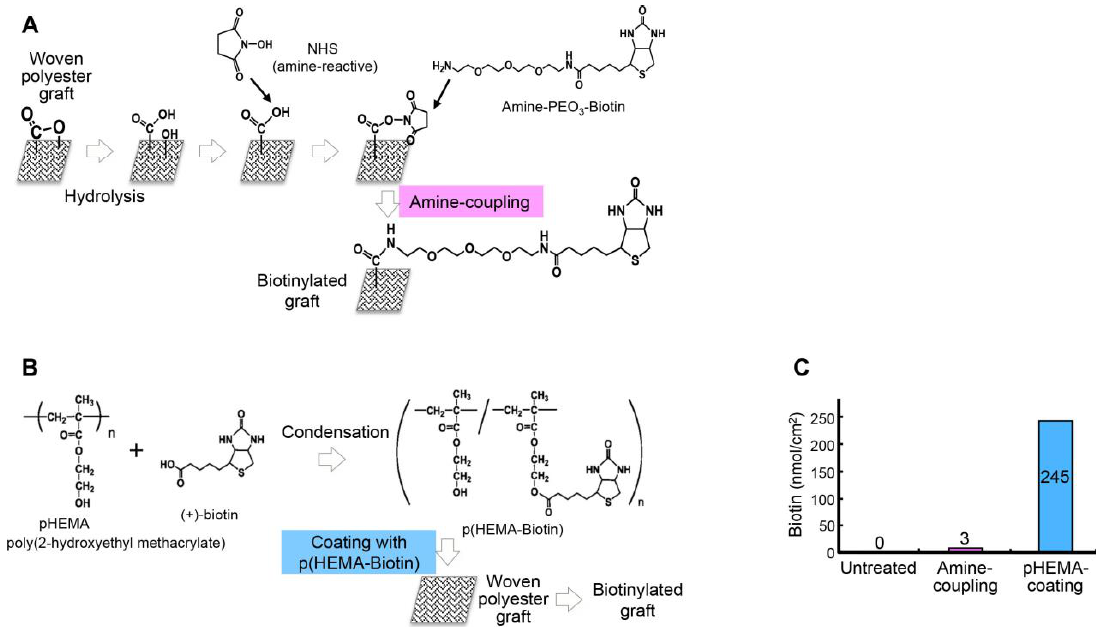
Figure 2. Development of the biotinylated graft. ( A ) Schematic diagram illustrates the preparation of the biotinylated graft with an amine-coupling reaction. ( B ) Schematic diagram illustrates the preparation of the biotinylated graft by coating with poly (2-hydroxyethyl methacrylate) (pHEMA). ( C ) Quantification of the amounts of biotin on the graft surfaces.